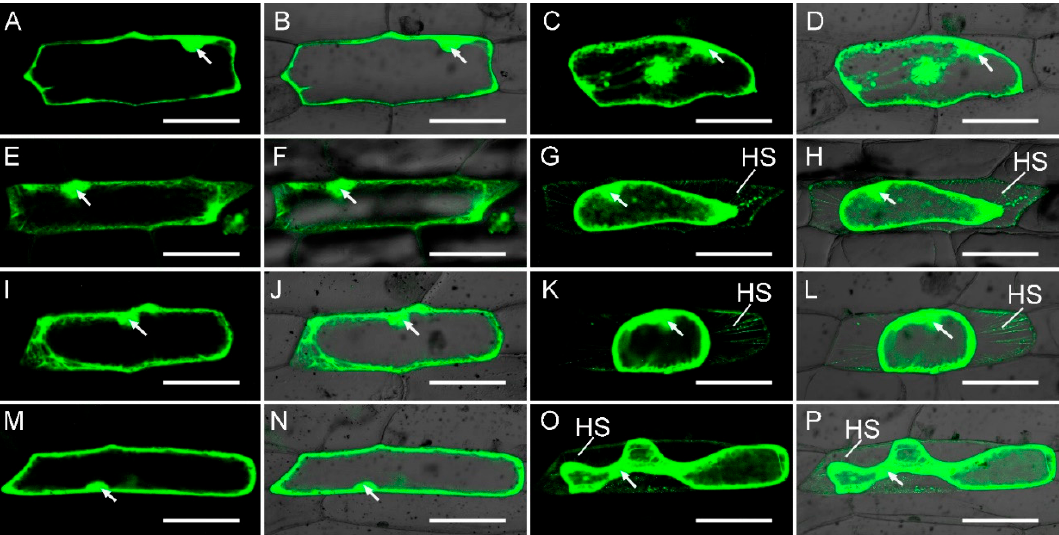
Figure 6. Expression of GFP–BrFLA fusion constructs in transgenic onion epidermal cells. Detection of GFP fluorescence in onion epidermal cells expressing pFGC–eGFP (Control) ( A – D ), GFP–BrFLA2 ( E – H ), GFP–BrFLA28 ( I – L ) and GFP–BrFLA32 ( M – P ) before ( A , B , E , F , I , J , M , N ) and after ( C , D , G , H , K , L , O , P ) treatment with 0.3 g·mL –1 sucrose for 3 min. White arrows indicate the nuclei of onion epidermal cells. HS, Hechtian strands. Scale bars = 100 μ m.